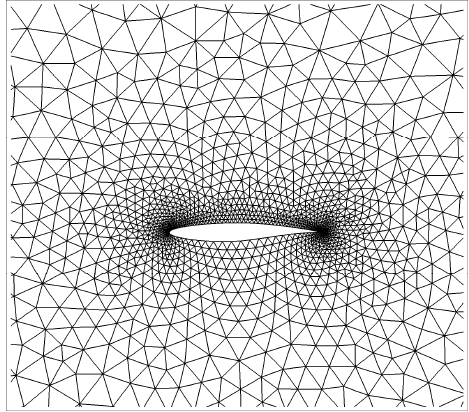
Figure 7. Computational mesh around RAE2822 airfoil.